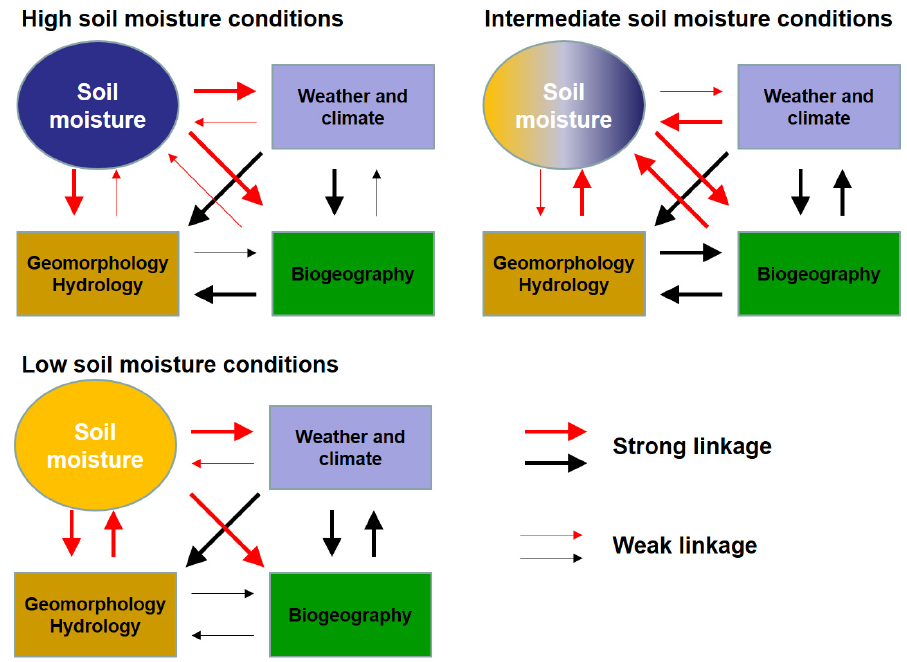
Figure 1. Illustration of linkages among soil moisture, weather and climate, geomorphology, hydrology, and biogeography for high ( upper left ), intermediate ( upper right ), and low ( lower left ) soil moisture conditions (adapted from Legates et al. [22]). The red linkages indicate direct relationships between soil moisture and weather/climate, geomorphology/hydrology, and biogeography. The black arrows indicate linkages independent of soil moisture.